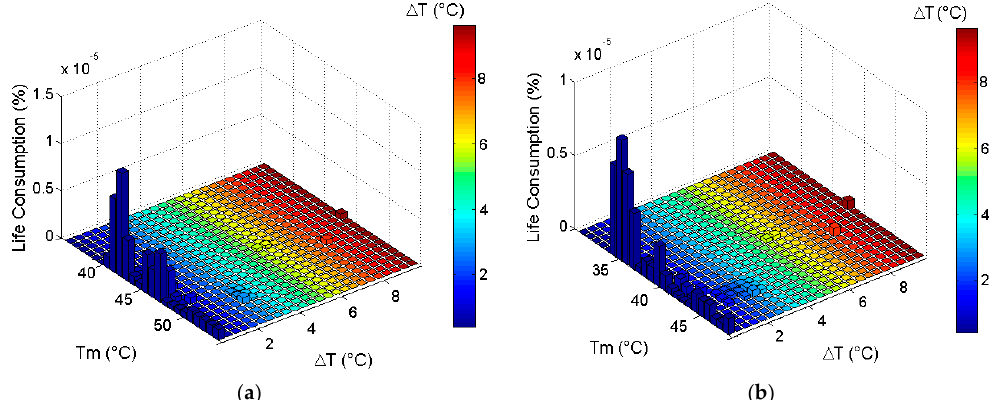
Figure 23. Lifetime Consumption with ( a ) IC and ( b ) P&O algorithms.